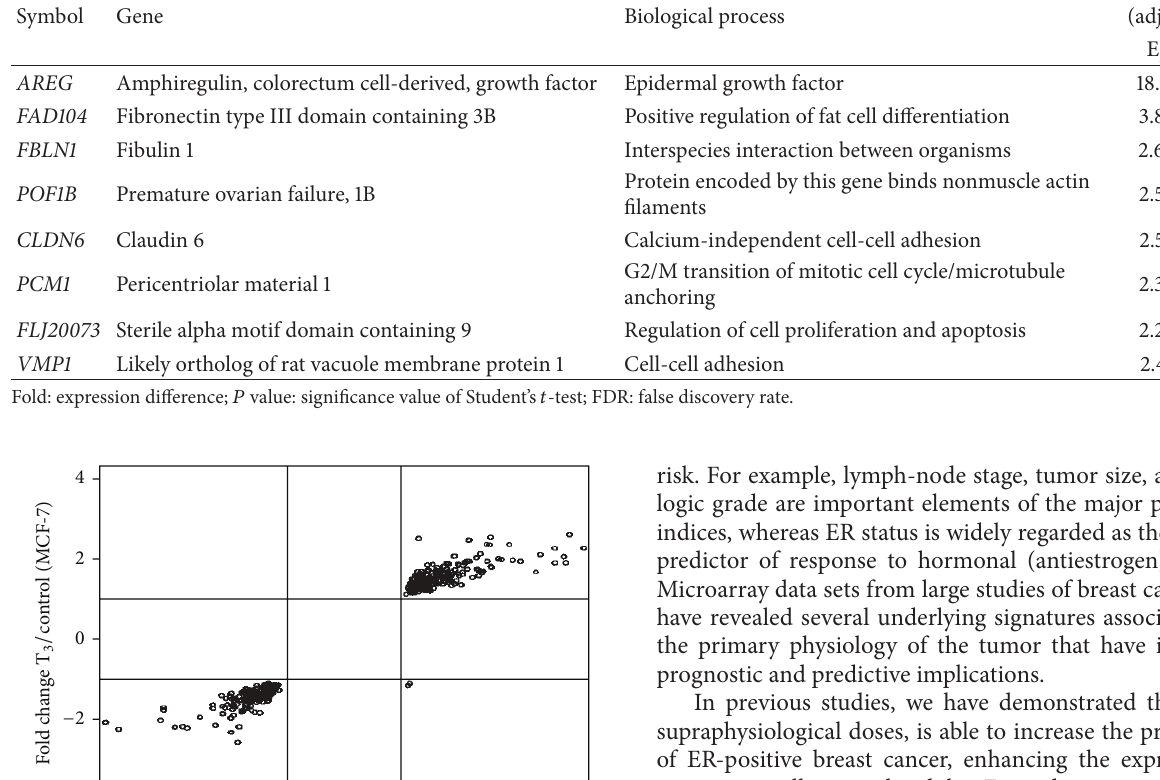
Table 1: Genes significantly modulated by E